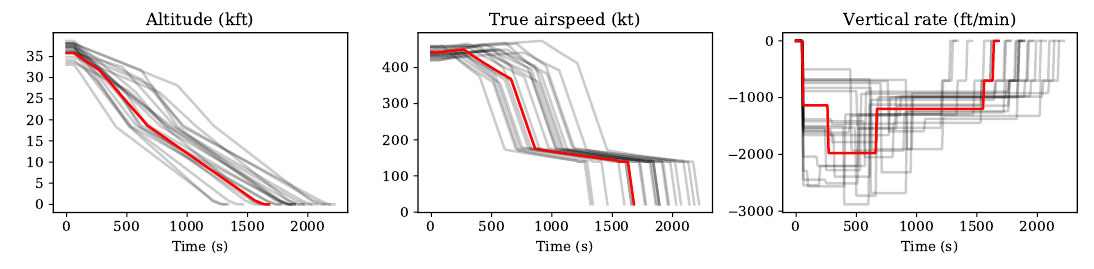
Figure 8. Generated descent trajectory (Airbus A320).